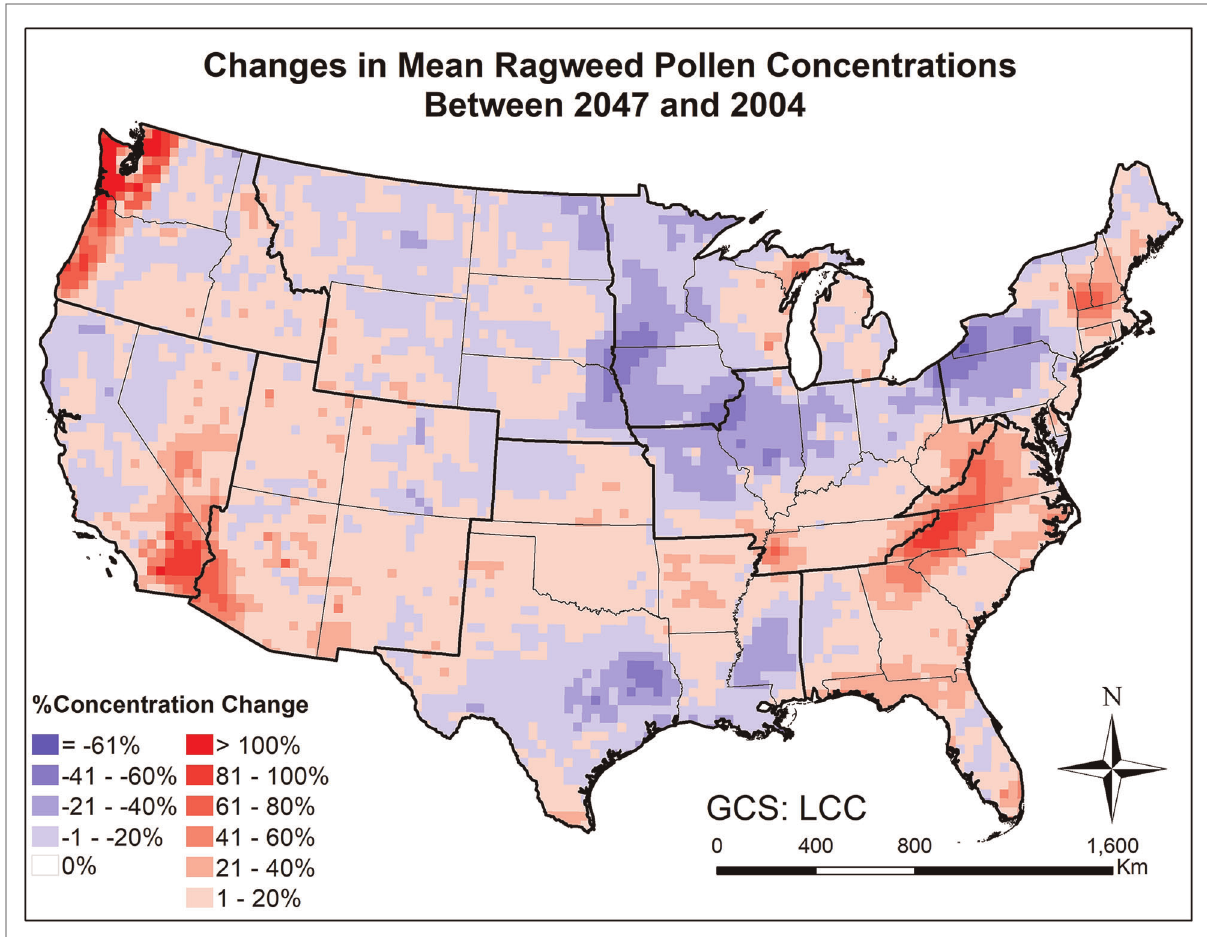
FIGURE 9 Changes in mean August-September ragweed pollen concentrations from beginning (2004) to mid-21st century (2047) estimated for the RCP8.5 climate change scenario using the CMAQ-Pollen model.